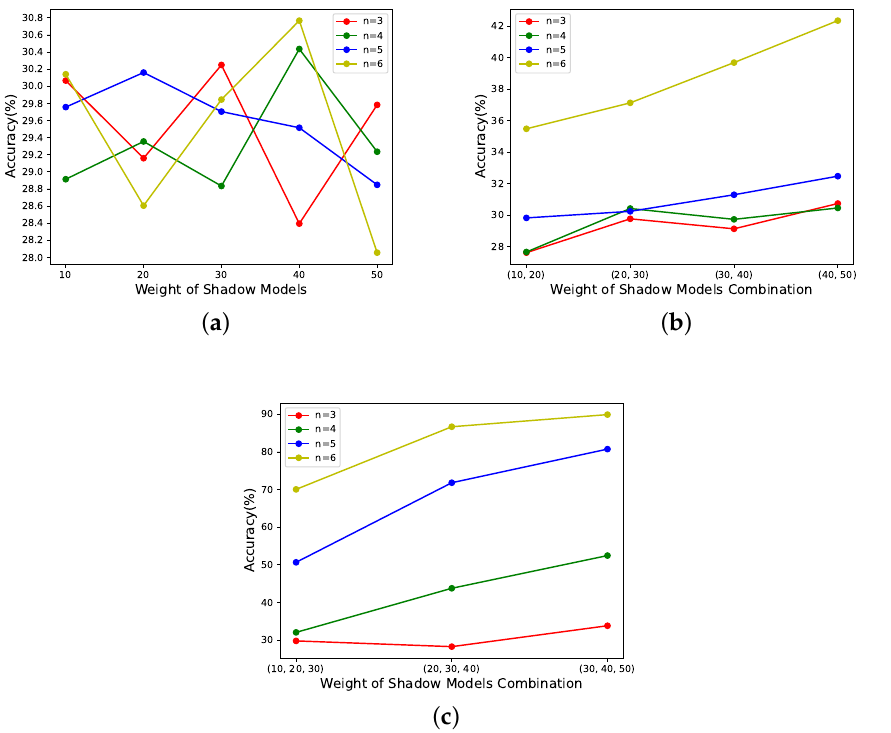
Figure 9. The relationship between the performance of reconstructed model and weight of shadow models with the weights other than 1 for different determined sharing states. ( a ) The number of shadow models with weights other than 1 in set x is 1. ( b ) The number of shadow models with weights other than 1 in set x is 2. ( c ) The number of shadow models with weights other than 1 in set x is 3.